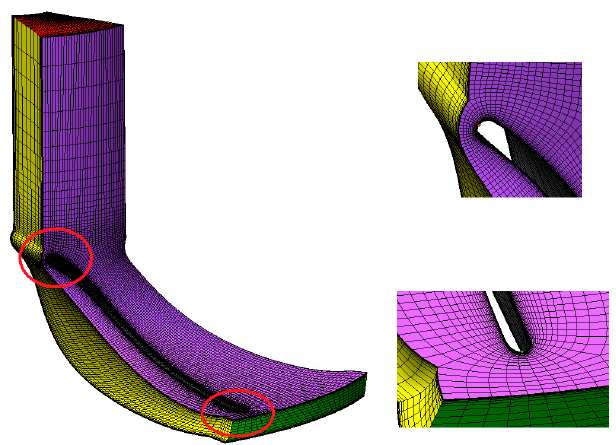
Figure 5. Mesh of Figure 5. Mesh of impeller.